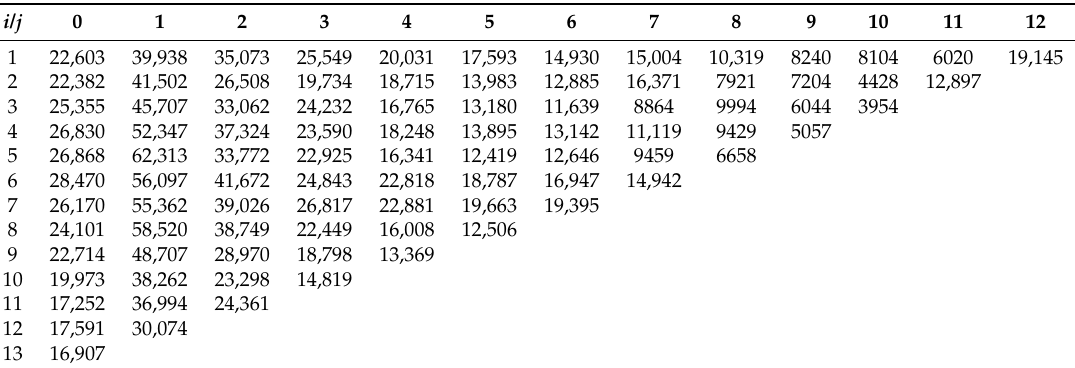
Table 2. Incremental payment used in the empirical application (,000).